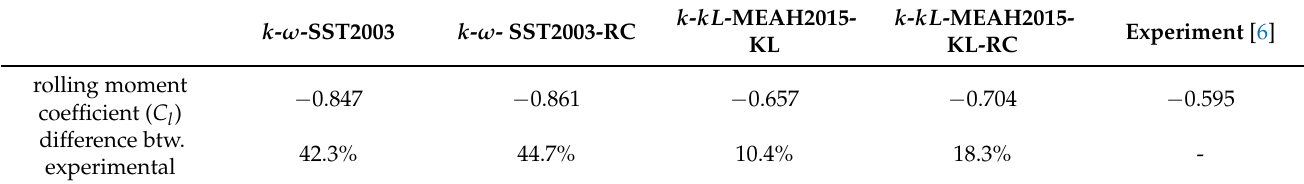
Figure 14. Normalized turbulent kinetic energy field in transverse planes; M = 0.85, Re d λ = 45°; Row 1: k - ω -SST2003, Row 2: k - ω -SST2003-RC, Row 3: k - kL -MEAH2015-KL, Row 4: k - kL - MEAH2015-KL-RC. Table 5. Computed rolling moment results with different rotational correction